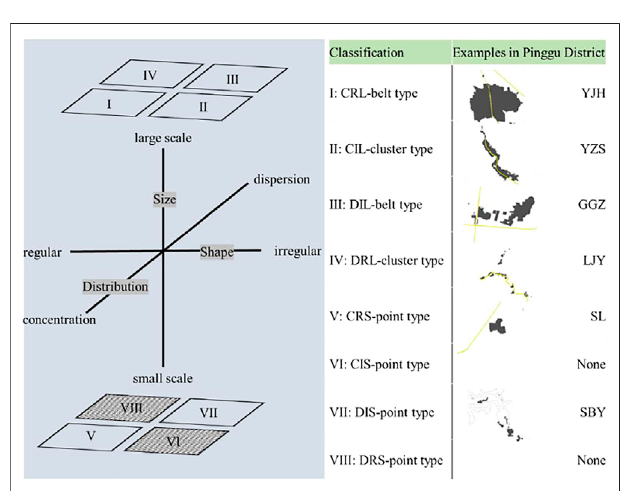
FIGURE 3 | Identi fi cation method and layout classi fi cation of rural residential